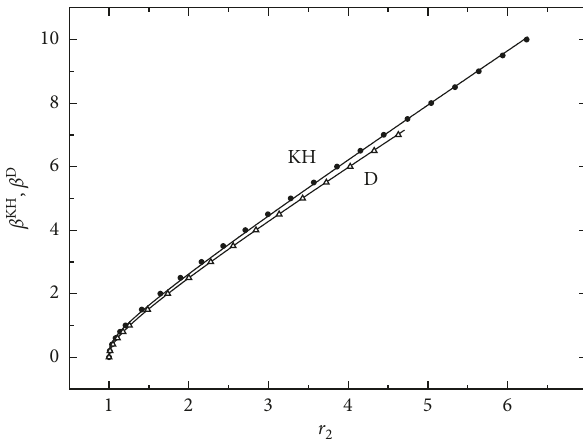
Figure 5: The relationship between the value of r tribution parameters for the Koiwa–Hasiguti peaks β KH (the present work) and for the Debye peaks β D (the data from [14] were processed). The points correspond to numerical calculations; the solid lines show the approximations β KH ( r 2 ) and β D ( r 2 ) ((25) and (26),